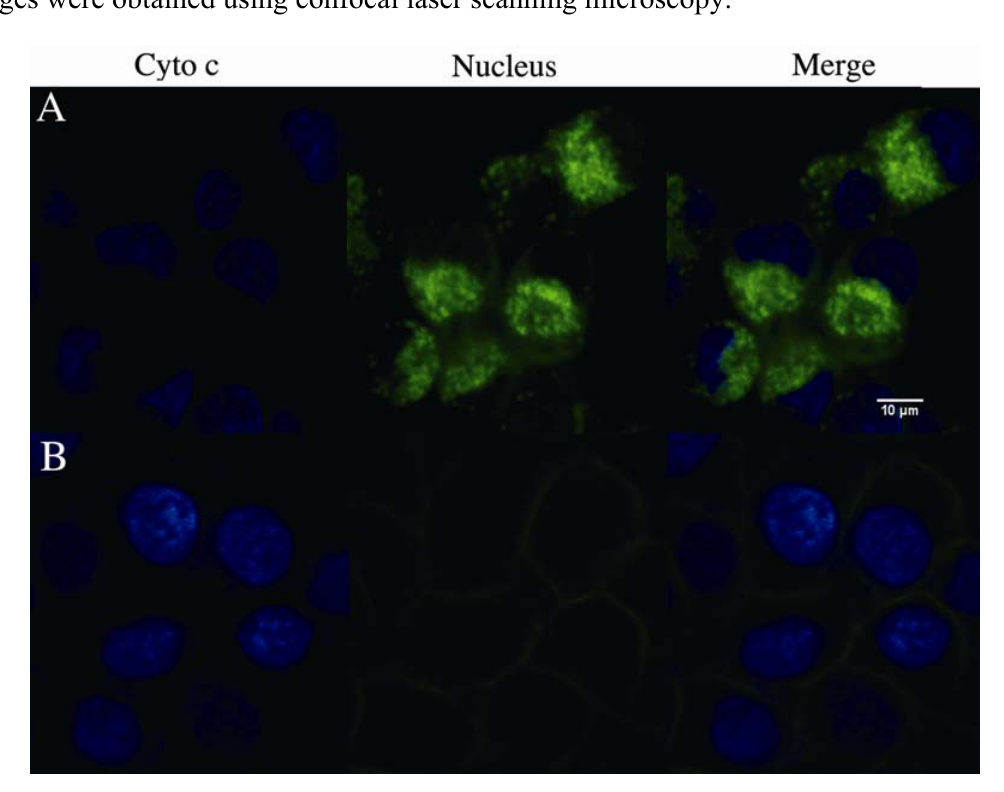
6. Effect of rVAA-I on the cytochrome c release from mitochondria. ( A ) SMMC-7721 cells with confocal medium and ( B ) cells treated with of 16 ng/mL rVAA-I for 24 h were fixed and labeled for cytochrome c (green) and nucleus (blue). Images were obtained using confocal laser scanning